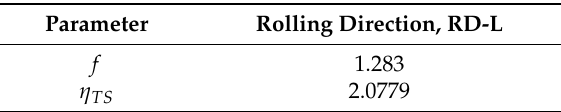
Table 1. Constraint factor values at maximum force.